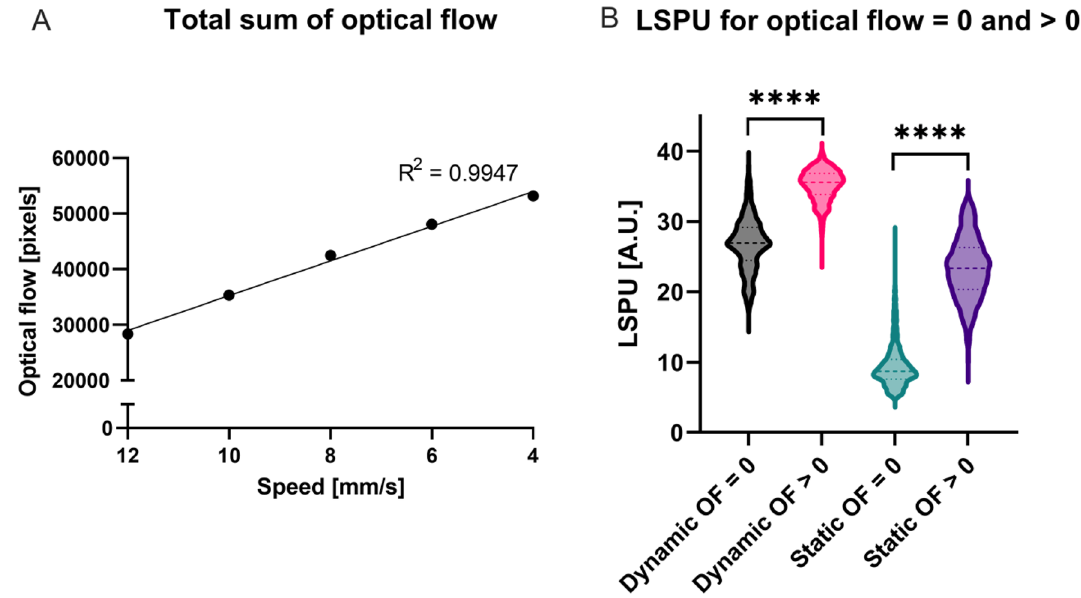
Figure 2. ( A ) Sum of optical flow measured per movement speed in mm/s with a linear fit. The R-squared for a linear fit is 0.9947. ( B ) A box-and-violin plot of the laser speckle perfusion units (LSPU) sorted by the measured optical flow (OF). To investigate the use of optical flow as an indication for motion artefacts, we studied the relation between OF and non-stabilized LSPU. LSPU sorted by OF values of = 0 and > 0. **** are significantly different (p <